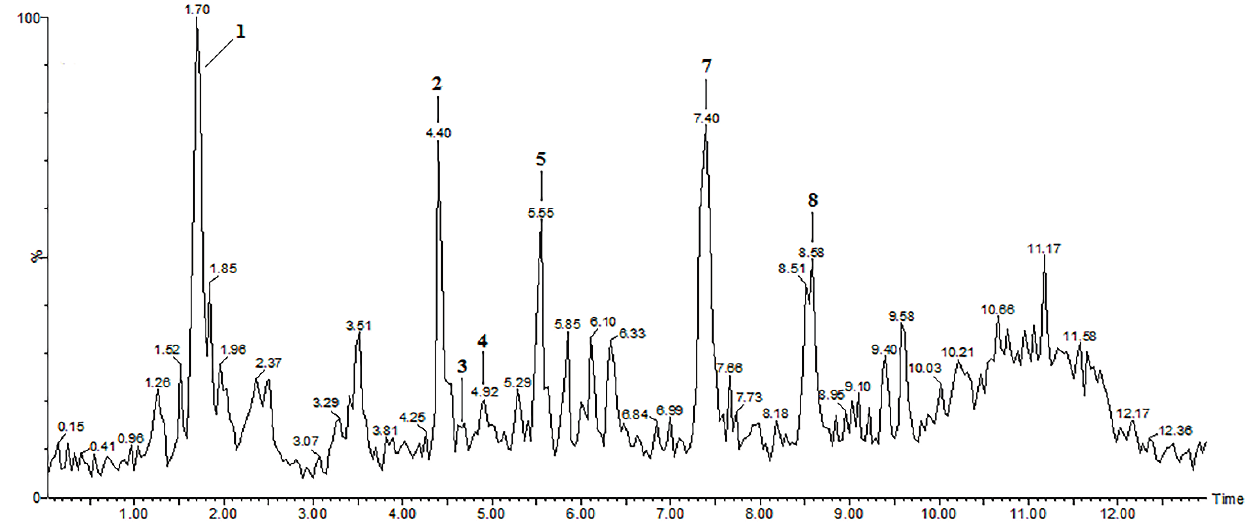
Figure 4. LC-ESI-MS total ion chromatogram (TIC) of the extract of Pfaffia glomerata inflorescences showing peaks 1 , 2 , 3 , 4 , 5 , 7 and 8 detected in the negative ion